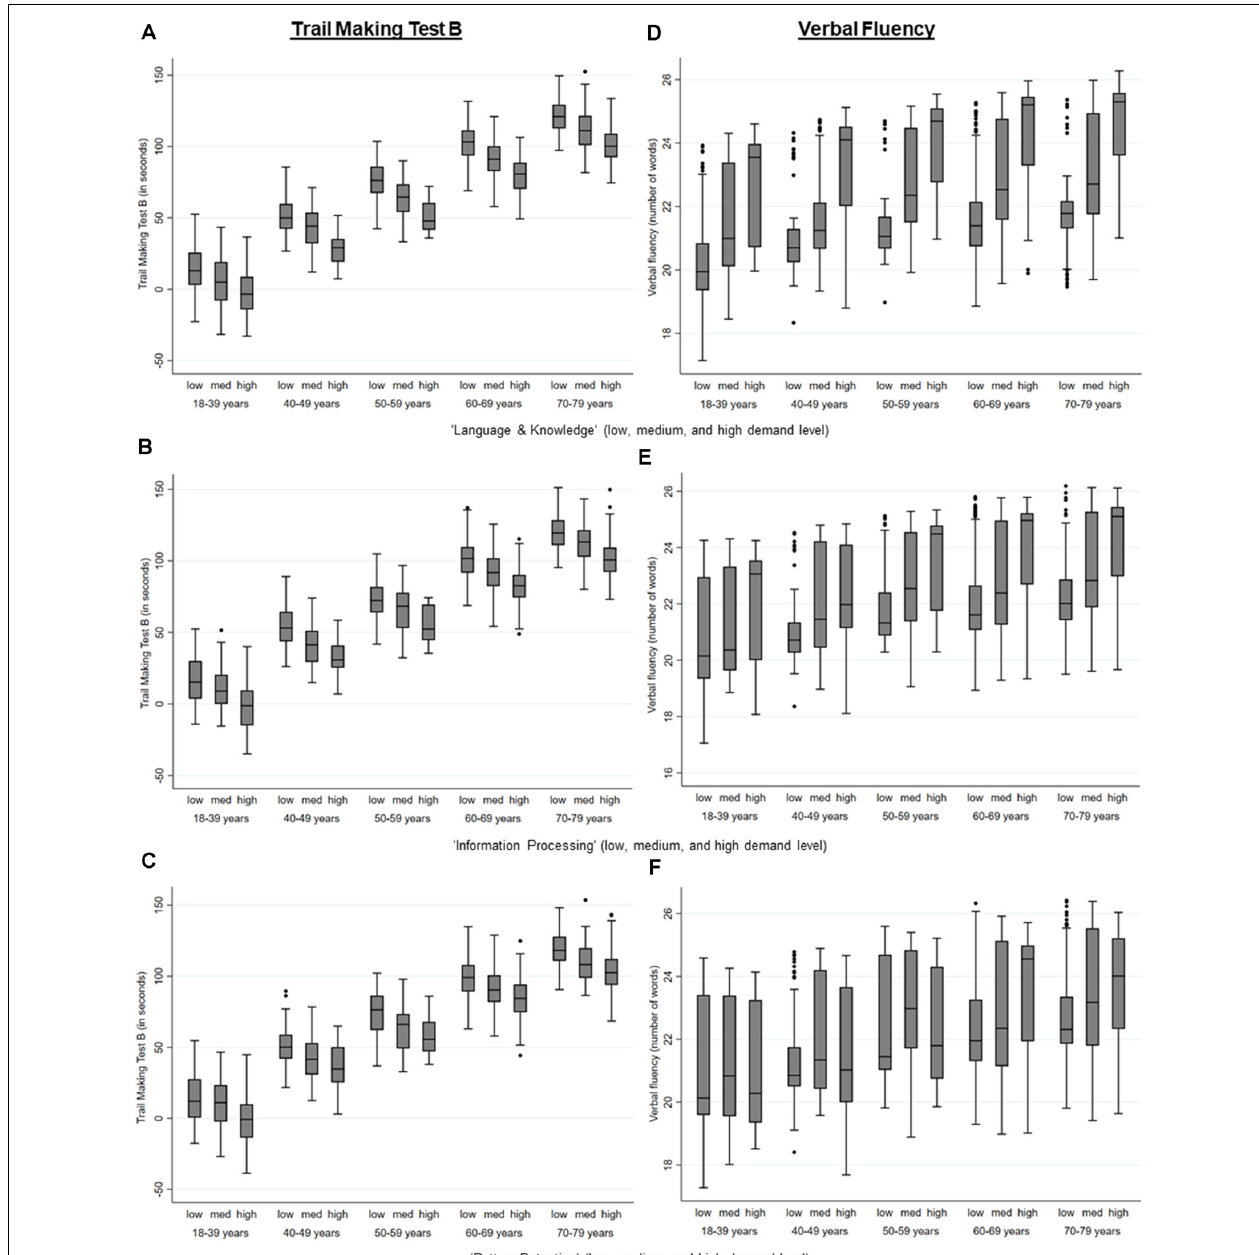
FIGURE 1 | Performance in the Trail Making Test B and the Verbal fluency test by the level of mental demands at work (MDW) and age, estimated via regression analyses separate for those that are retired and those that are not retired an adjusted for age, gender, education, APOE e4-allele, hypertension, and diabetes. (A) Level of the mental work demand, Language & Knowledge on performance in the Trail Making Test B. (B) Level of the mental work demand, Information Processing on performance in the Trail Making Test B. (C) Level of the mental work demand, Pattern Detection on performance in the Trail Making Test B. (D) Level of the mental work demand, Language & Knowledge on performance in the Verbal Fluency Test. (E) Level of the mental work demand, Information Processing on performance in the Verbal Fluency Test. (F) Level of the mental work demand, Pattern Detection on performance in the Verbal Fluency